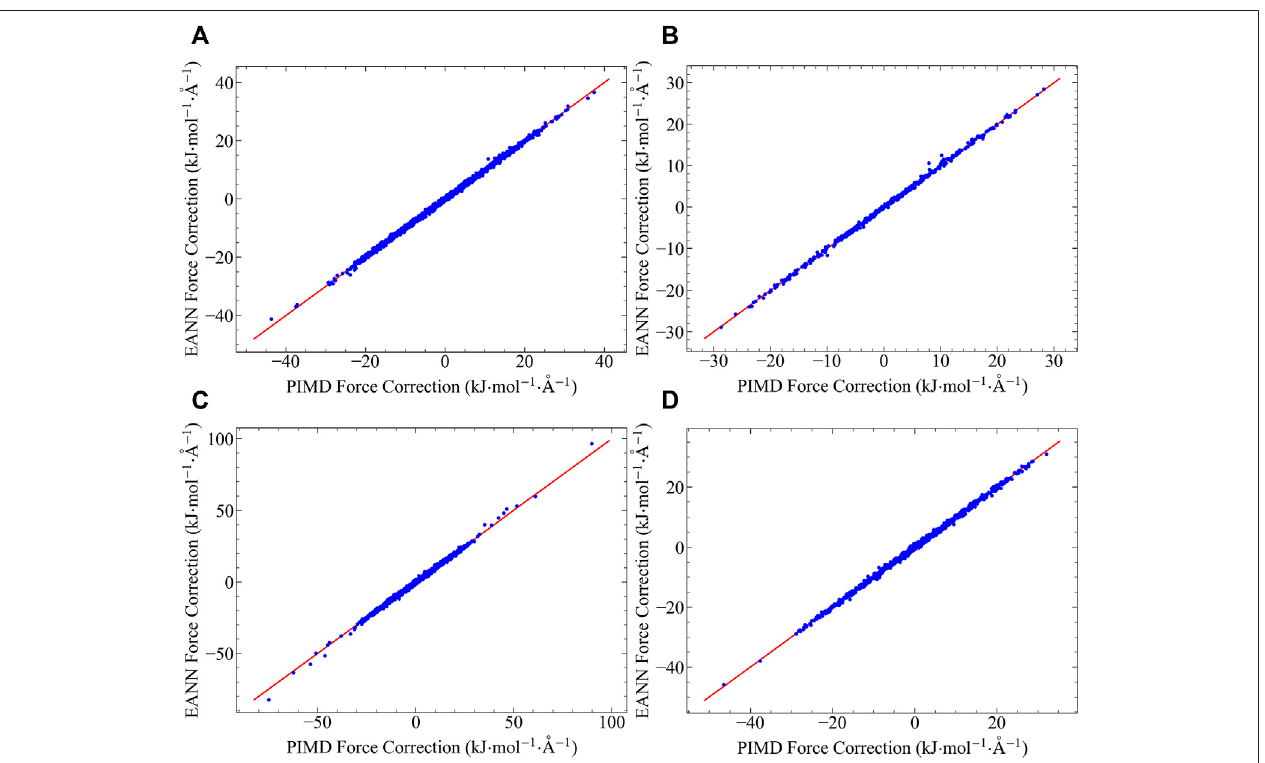
FIGURE 2 | Quantum force corrections predicted by the EANN model, plotted against the reference data computed using PIMD: (A) Results in bulk water with q-TIP4P/F force fi eld. (B) Results in surface water with q-TIP4P/F force fi eld. (C) Results in bulk water with AMOEBA force fi eld. (D) Results in surface water with AMOEBA force fi